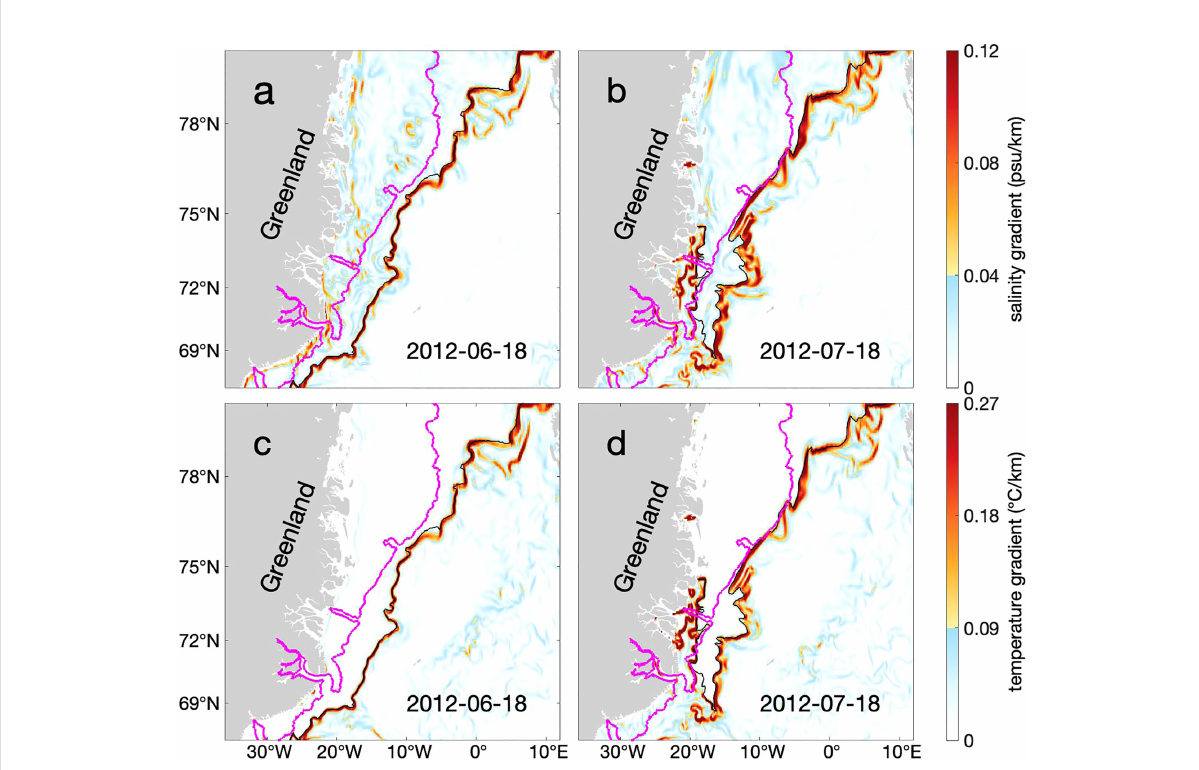
FIGURE 4 Spatial distributions of the ice edge, salinity front, and temperature front in the Greenland Sea on 18 June and 18 July 2012. (A, B) Horizontal gradient of sea surface salinity and (C, D) horizontal gradient of sea surface temperature. The black line is the daily ice edge, and the purple line is the 330-m isobath that represents the shelf break with a high topography